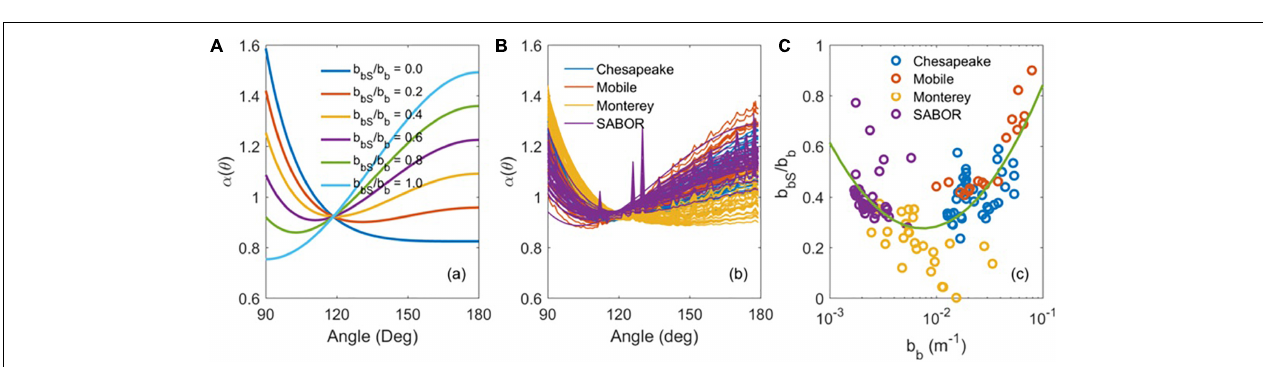
FIGURE 4 | (A) The variation of hypothetical particle scattering shapes (VSF at angles 90 ◦ –180 ◦ normalized by the backscattering coefficient) constructed by linear mixing of the two end members. The legend shows fractional b b contributed by small particles. (B) The particle backscattering shapes measured in coastal waters of Chesapeake Bay, Mobile Bay, and Monterey Bay and during the SABOR cruise in North Atlantic Ocean. (C) The mixing ratios estimated by applying the two-component model in panel (A) to measured VSF shapes in panel (B) are shown as a function of particle backscattering